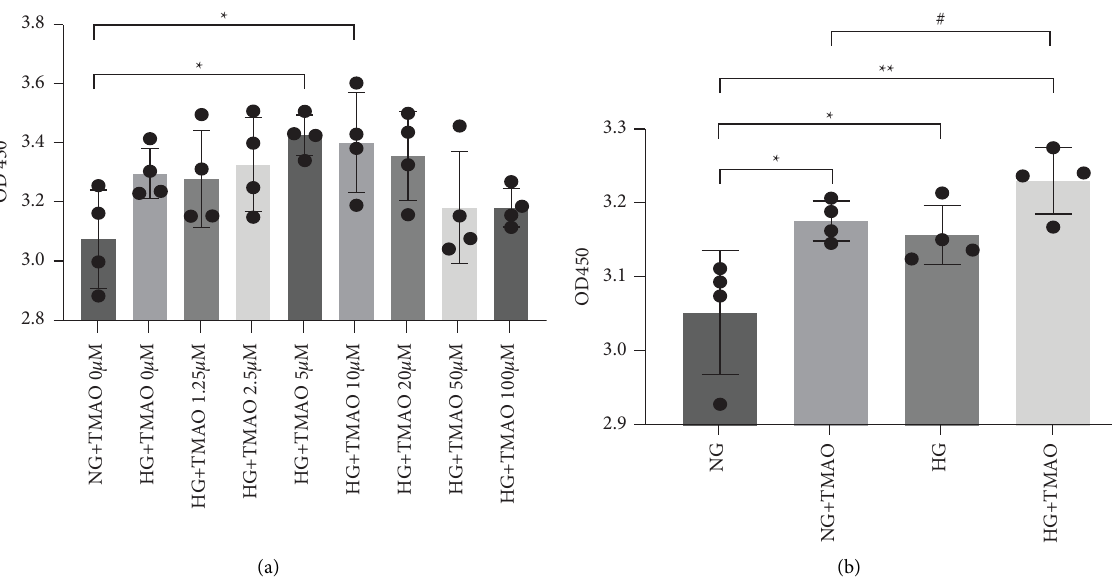
Figure 2: TMAO promotes cell proliferation induced by high glucose in human retinal microvascular endothelial cells. HRMECs were treated with NG (normal glucose, D-glucose 5.5mM) +TMAO (0 μ M) and HG (high glucose, D-glucose 30mM) +TMAO (0, 1.25, 2.5, 5, 10, 20, 50, 100 μ M) for 72h. (a) OD450 values were read after 2h of adding CCK8 solution. ∗ P < 0 . 05 vs. NG+TMAO (0 μ M), n � 4. HRMECs were treated with NG (D-glucose, 5.5mM), NG+TMAO (5 μ M), HG (D-glucose, 30 mM), and HG +TMAO (5 μ M) for 72h. (b) OD450 values were read after 2h of adding CCK8 solution. ∗ P < 0 . 05 vs. NG; # P < 0 . 05 vs . NG+TMAO, n � (Figure 5(c)). Te protein expression levels of NLRP3 (Figure 5(d)), ASC (Figure 5(e)), Caspase-1 (Figure 5(f)), cleaved-Caspase-1 (Figure 5(g)), IL-1 (Figure 5(h)), and Pro- IL-1 β (Figure 5(i)) were found to be increased by the com-